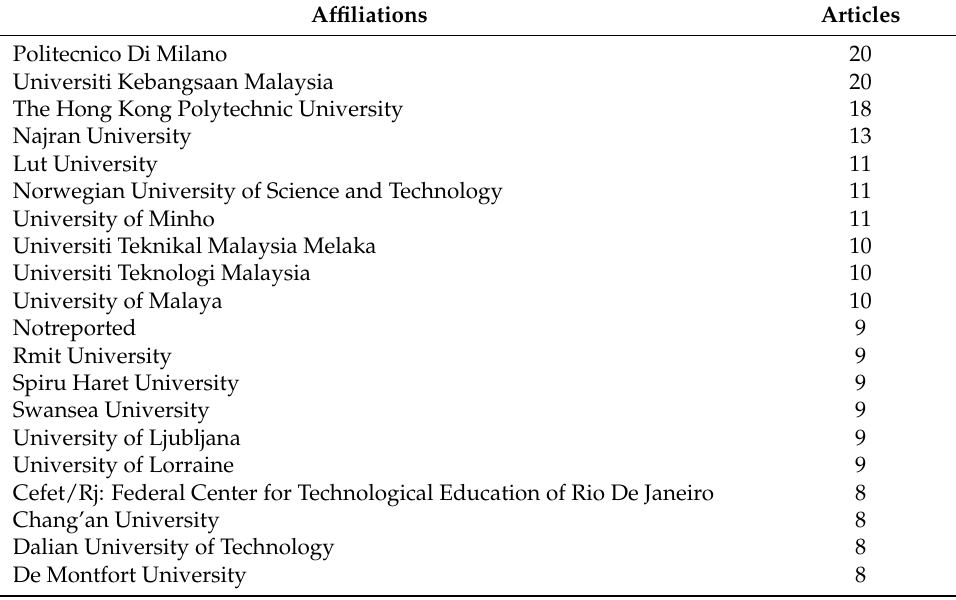
Table 4. Most relevant institutions.